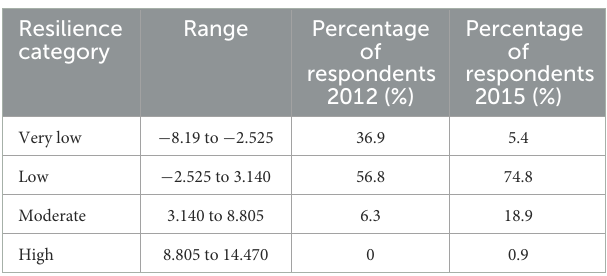
TABLE 4 Resilience scores